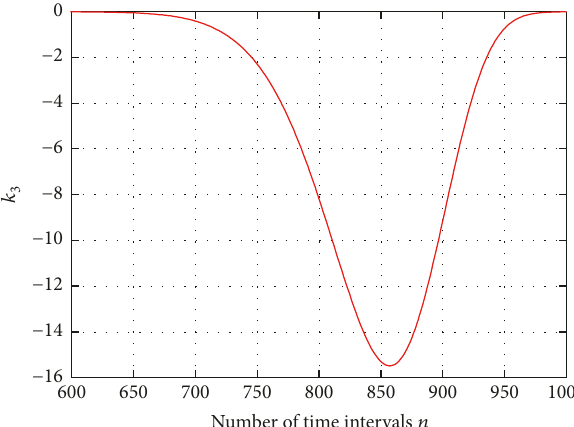
Figure 10: Sensitivity with respect to 𝛽(𝑁 𝑖 )